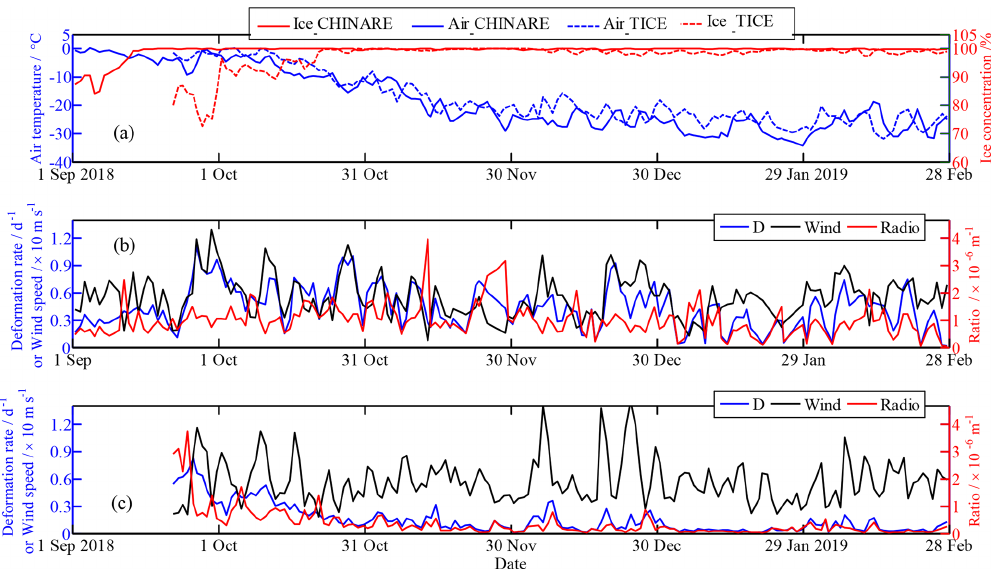
Figure 11. (a) Time series of daily average near-surface (2m) air temperature and ice concentration within the CHINARE and TICE buoy clusters. Ice deformation rate ( D ), wind speed, and their ratio at the 10–20km scale for the (b) CHINARE and (c) TICE buoy